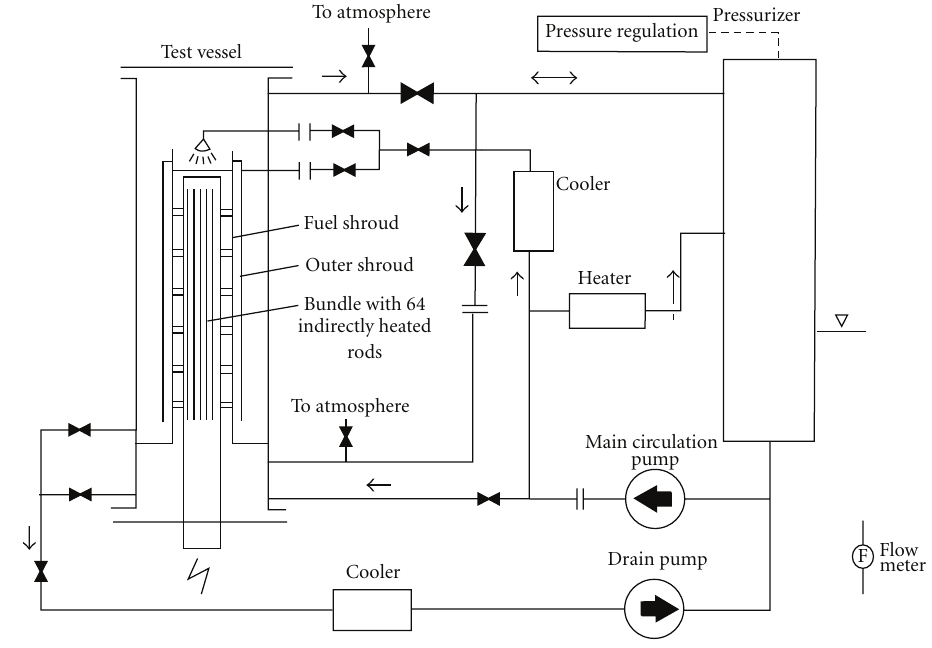
Figure 1: The G ¨OTA test